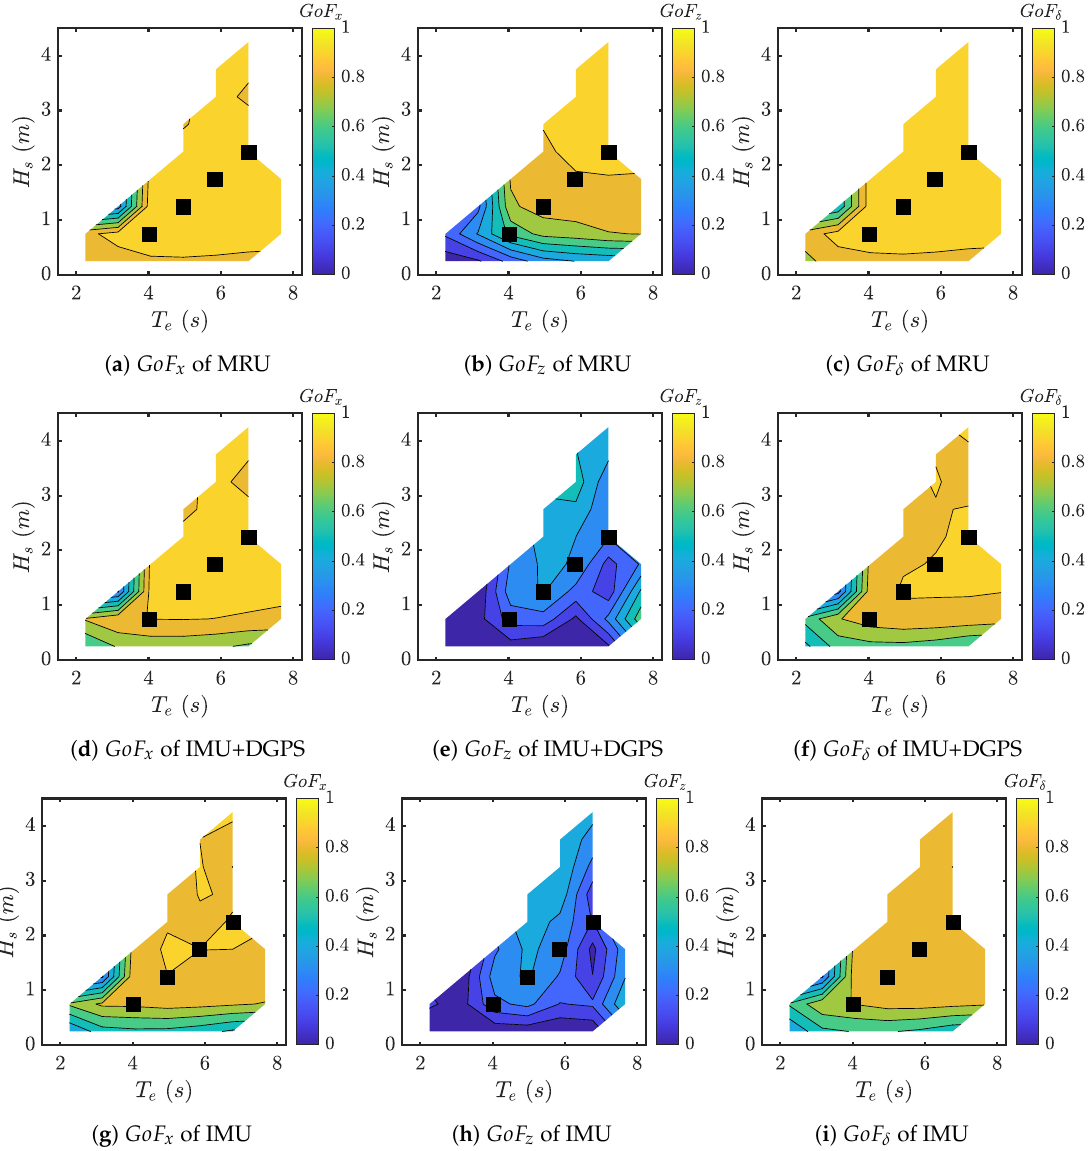
Figure A4. GoF results with noisy measurements for each measurement framework obtained with the NN. The first row refers to the MRU framework ( a – c ), the second to the IMU+DGPS framework ( d – f ), the thrid to the IMU framework ( g – i